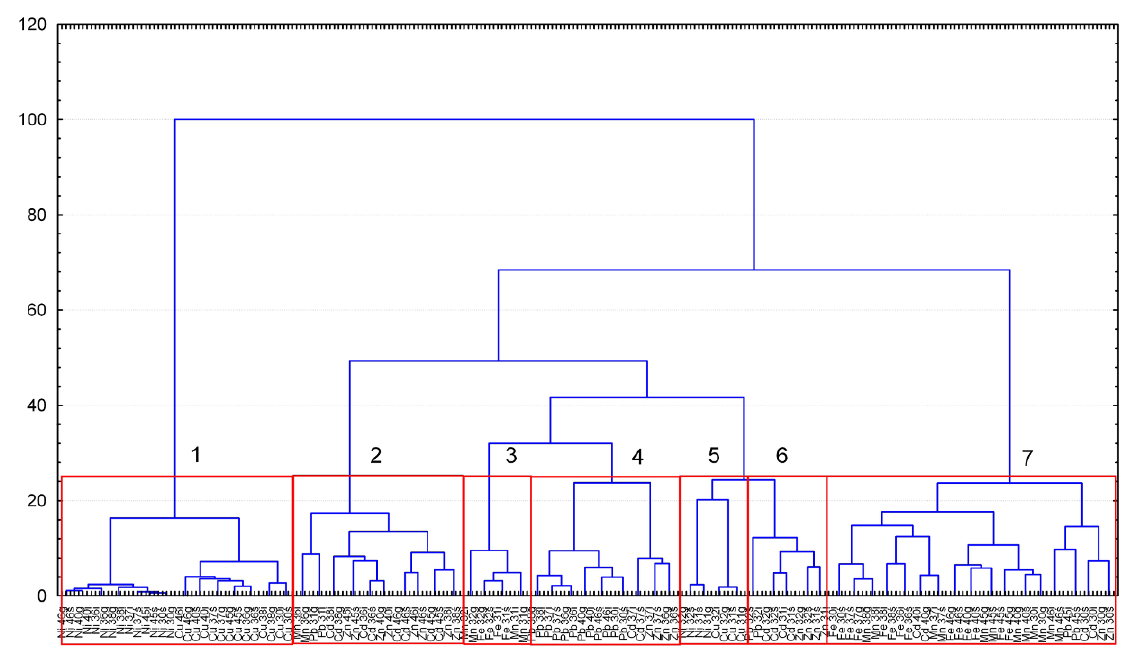
Figure 8. Concentration analysis dendrogram for all mineralised samples analysed.